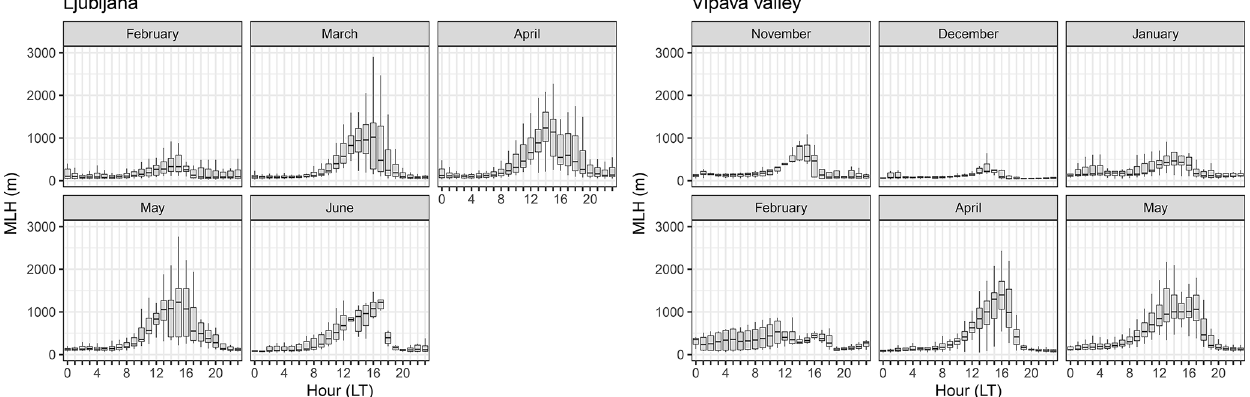
Figure 6. Diurnal variation (local time: CET/CEST) in modelled mixing layer height (MLH) grouped by months for the periods of thermally driven PBL convection, for Ljubljana and Vipava valley. Hourly statistics are represented by box plots (horizontal line: median; grey-coloured box: 25th–75th percentiles; whiskers: 5th–95th